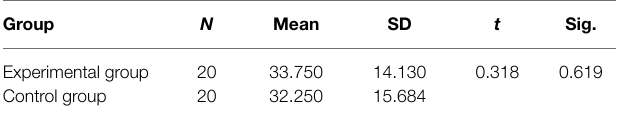
TABLE 2 | Analysis of the independent sample t -test of the posttest of two